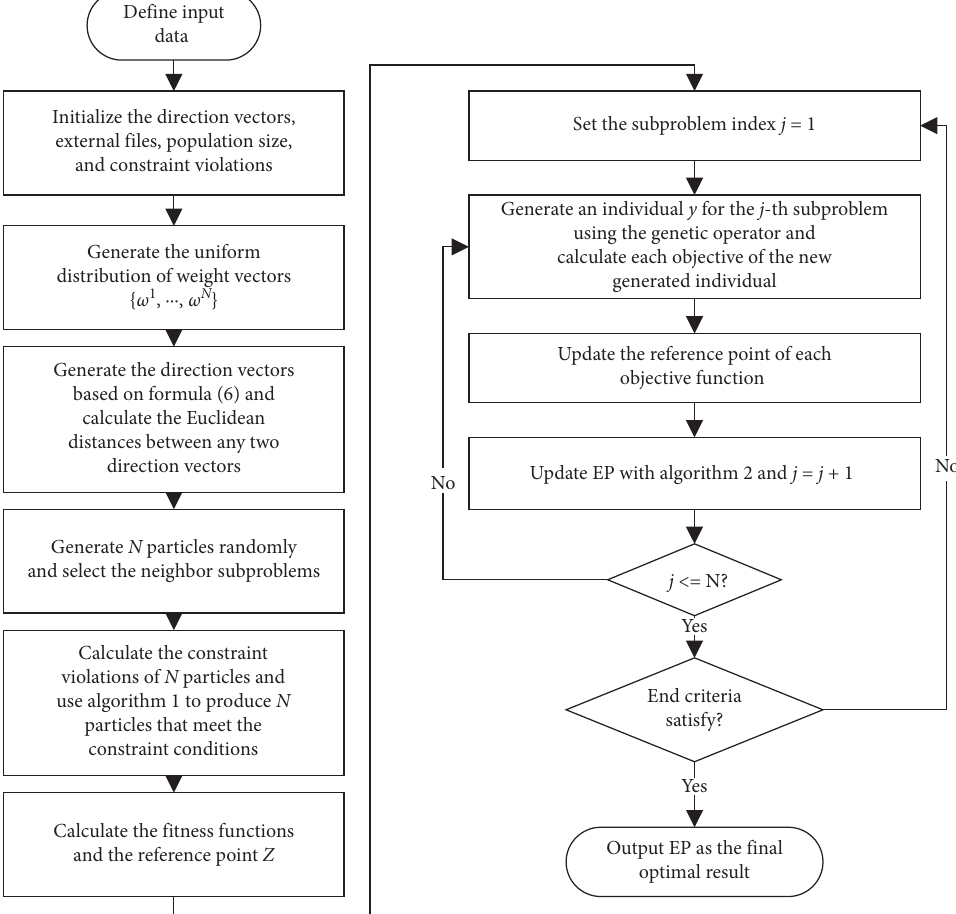
Figure 2: The general main framework of the modified